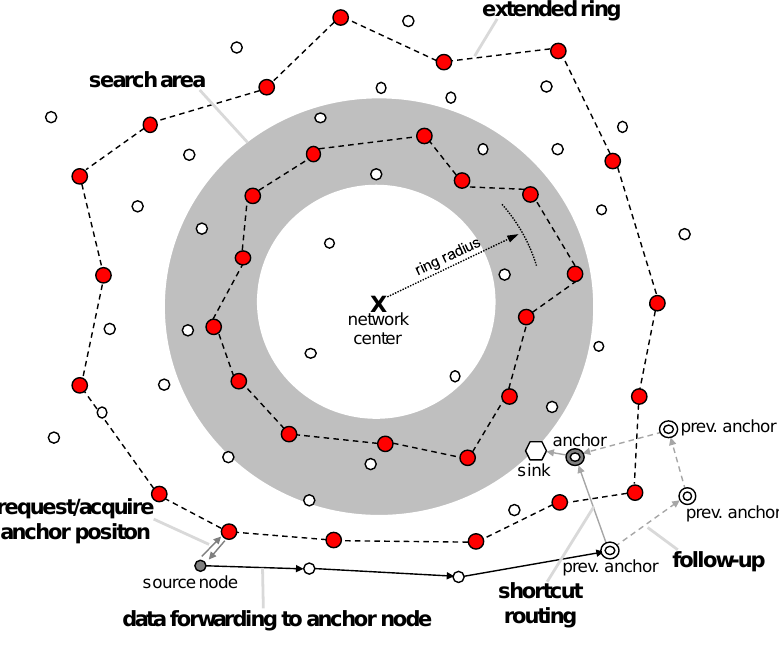
Figure 3. Overview of the MRR